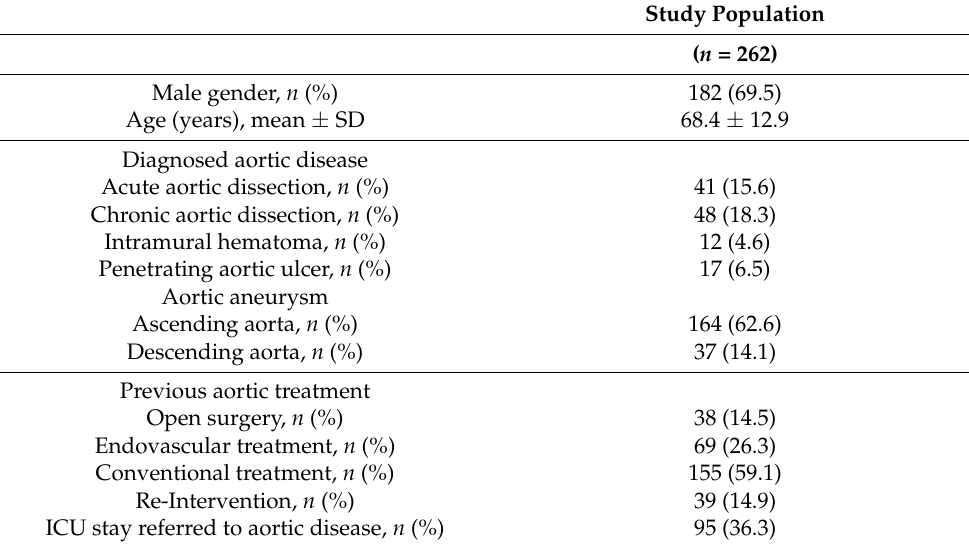
Table 1. Sociodemographic